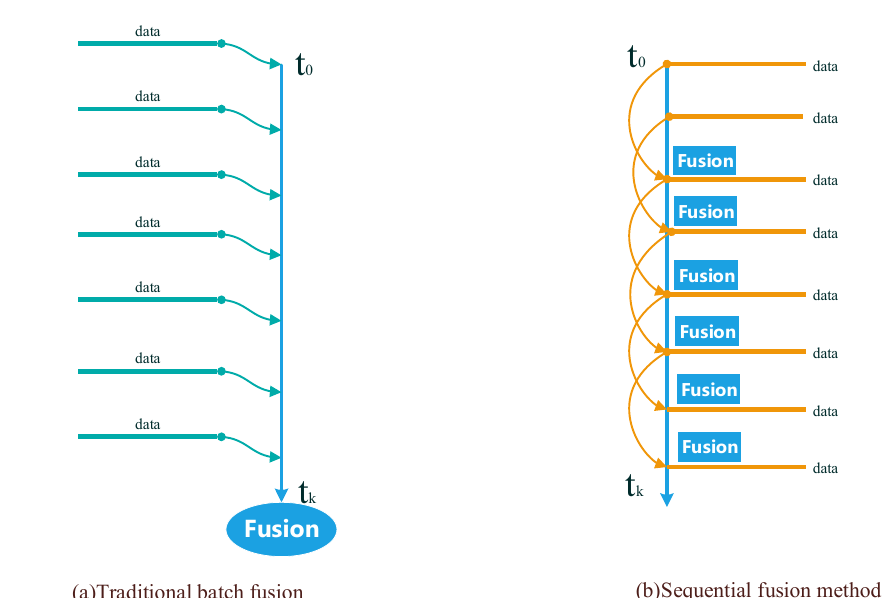
Figure 7. Procedure of improved unscented Kalman filtering.